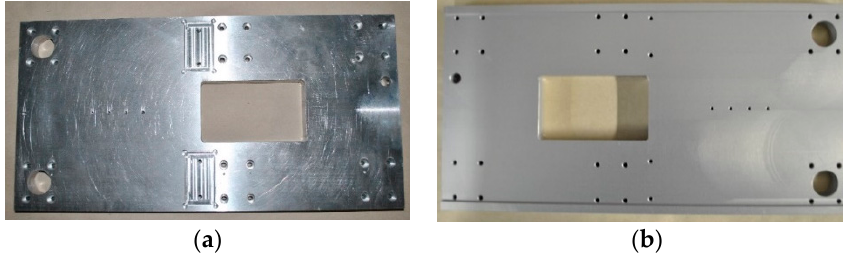
Figure 15. A plate ( a ) before and ( b ) after anodic oxidation by the GS method.